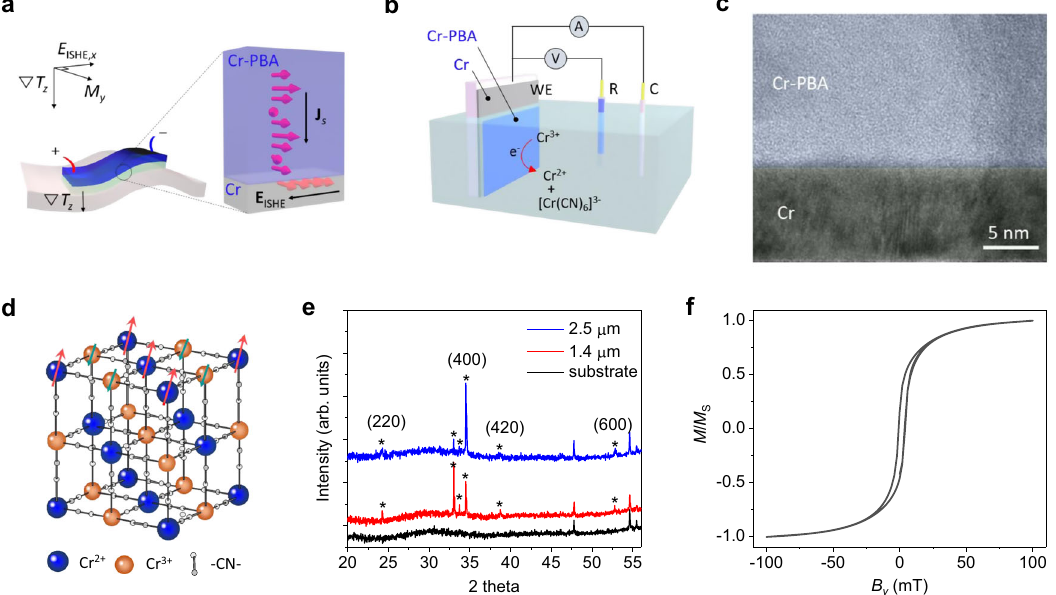
Fig. 1 STE coating and characteristics of the Cr-PBA thin fi lms. a Schematic illustrations of STE energy conversion upon the vertical temperature gradient ( ∇ T z ) and the mechanism of LSSE associated with thermally generated magnons and their conversion into a charge current via the ISHE. b Sketch of the ECD set-up for the Cr-PBA coating using a Cr thin fi lm (10 nm) as a working electrode (WE), Pt counter electrode (C), and Ag/AgCl reference cell (R). c The cross-sectional TEM image of a Cr-PBA/Cr bilayer deposited on an oxidized silicon substrate. d Crystal structure of Cr[Cr(CN) 6 ] displaying a ferrimagnetic con fi guration (antiparalleled Cr 2 + ( S = 2, t 2g 3 e g 1 ) and Cr 3 + ( S = 3/2, t 2g 3 ) spins via the superexchange coupling). e XRD spectra of Cr-PBA fi lms with deposition time of 600 and 1200 s, which are 1.4 and 2.5 μ m thick, respectively. f The magnetic hysteresis curve of the developed Cr-PBA fi lm measured for in-plane applied magnetic fi eld at 100